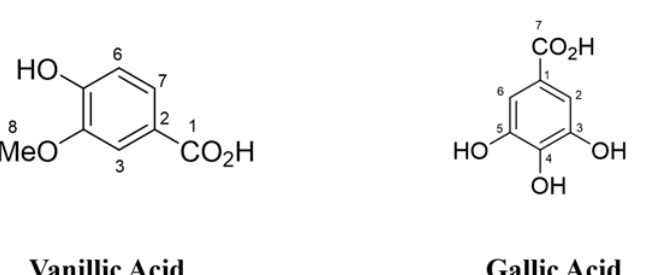
Figure 4. The chemical structures of vanillic acid and gallic acid obtained from the extracts of Wedelia chinensis .